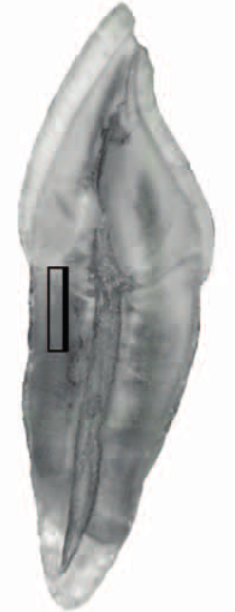
Figure 1. A rectangle on a photograph indicates the area where the dentinal sample was obtained from. The sample was obtained from the middle of the bulk of the labial side of dentin, in dimensions of 4x3x1 mm. The thicker line of the rectangle indicates the investigated dentin sample’s